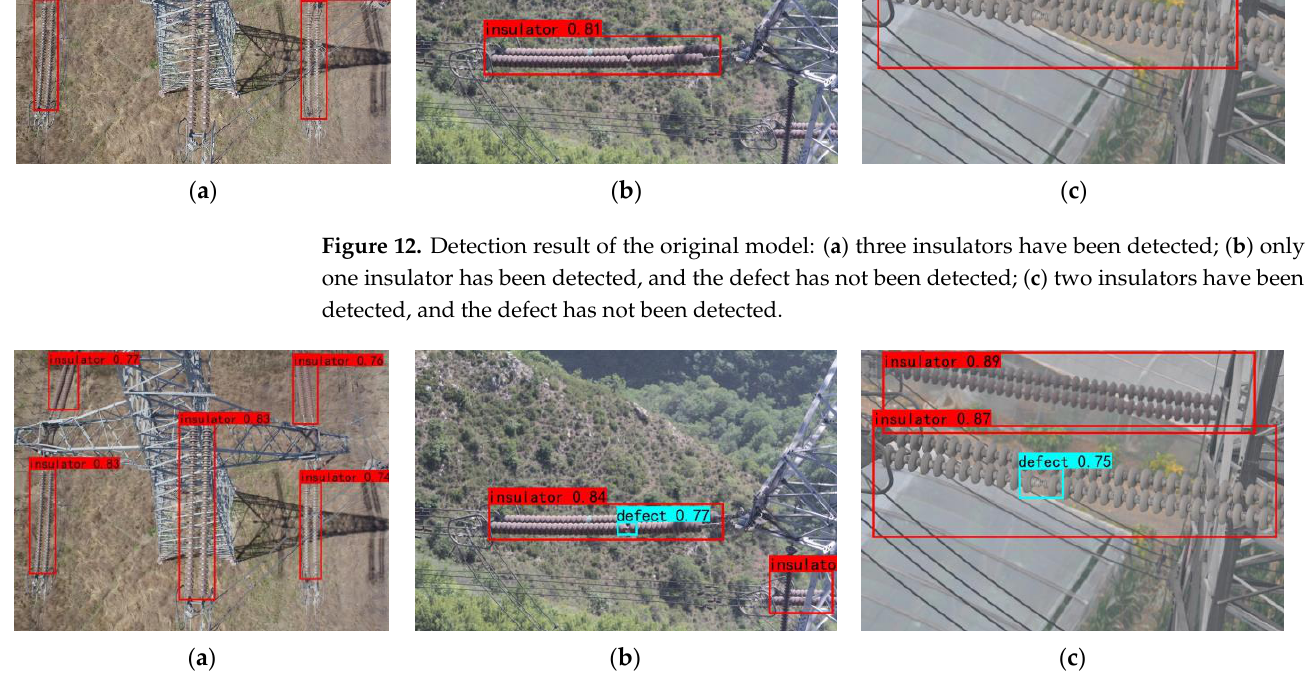
Figure 13. The detection result of the improved model: ( a ) five insulators have been detected; ( b ) two insulators and one defect have been detected; ( c ) two insulators and one defect have been de- tected.